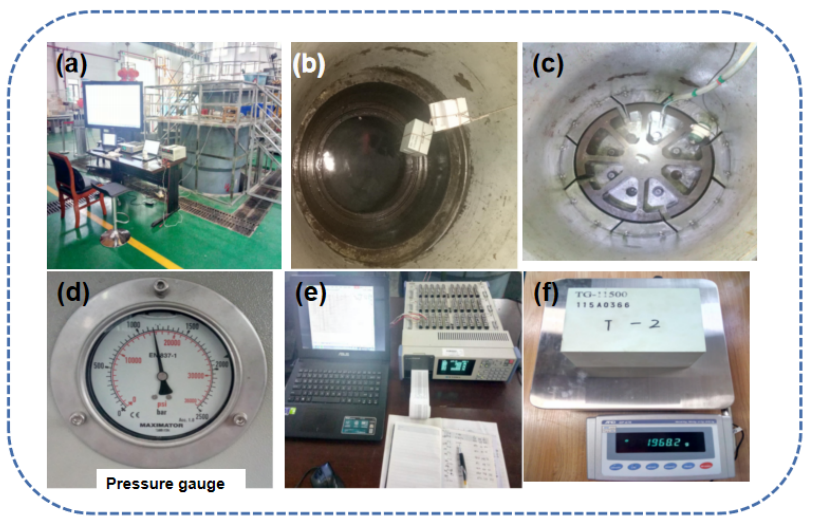
Figure 6. ( a ) The pressure chamber and monitoring system set-up; ( b ) placing buoyancy foam blocks into the chamber; ( c ) closing the chamber cover and getting ready for tests; ( d ) pressure gauge; ( e ) monitoring and data recording during tests; ( f ) weighing the block after the test. Table 2. Experimental results of buoyancy foam